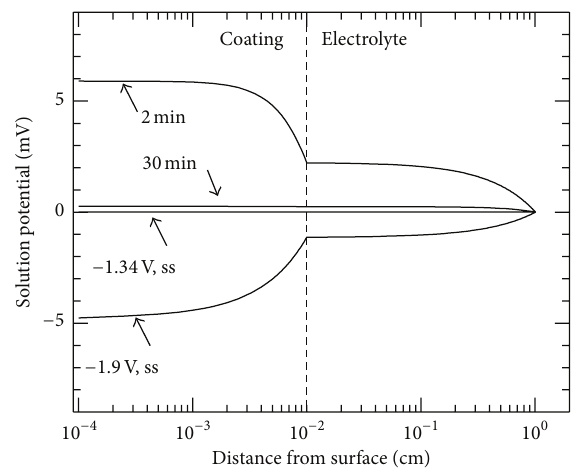
Figure 4: Solution potential as a function of distance from the metal surface across the coating and electrolyte for a 0.1mm thick, 0.02 porosity coating. Included are the steady state distributions at − 1.34 V and − 1.9V and the transient distributions at 2 min and 30 min after the applied potential of − 1.9V was switched off.